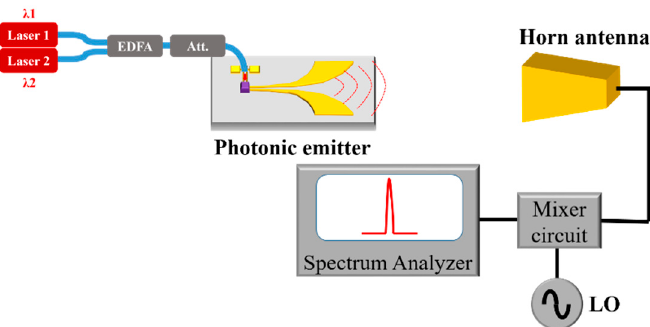
Figure 9. Experimental setup for measuring the radiation power of the photonic emitter at W-band. LO: local oscillator. The distance between photonic emitter and horn antenna was 60 cm.